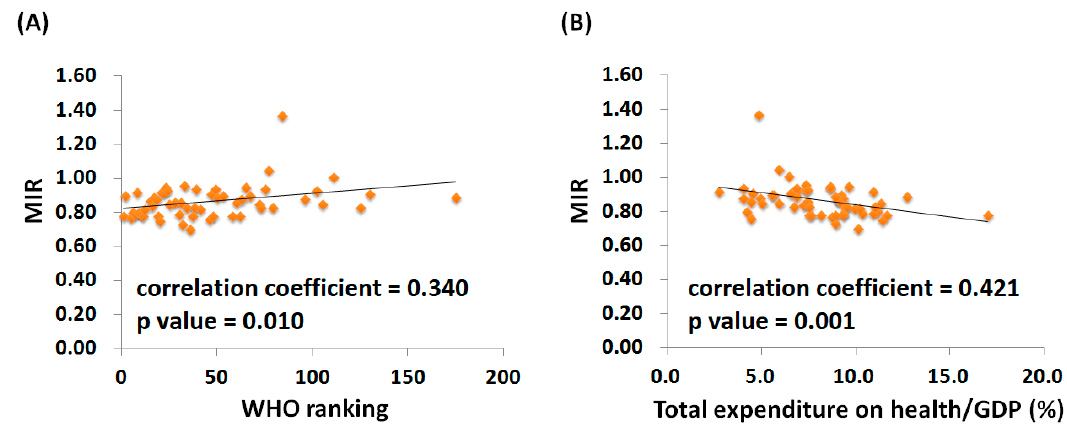
Figure 1. The ( A ) World Health Organization rankings and ( B ) total expenditures on health/GDP were associated with the mortality-to-incidence ratio (MIR) for lung cancer. The p value was determined by bivariate correlation using the Spearman correlation test. The country with an extreme value is Mauritius (MIR = 1.38).